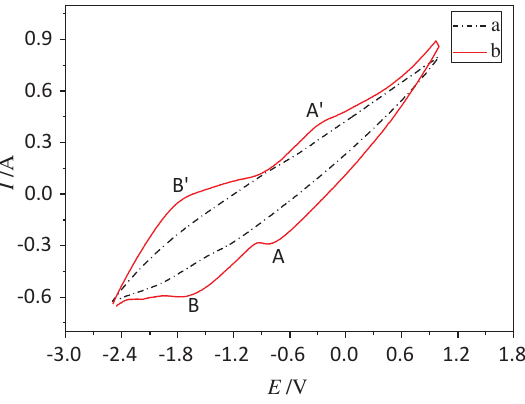
Figure 2: Cyclic voltammograms of NaCl-NaF-KCl melts (a) before and (b) after the addition of 0.177 mol·L − 1 SiO 2 at 1,103 K on Fe electrode. Scan rate: 0.9 V·s − 1 .